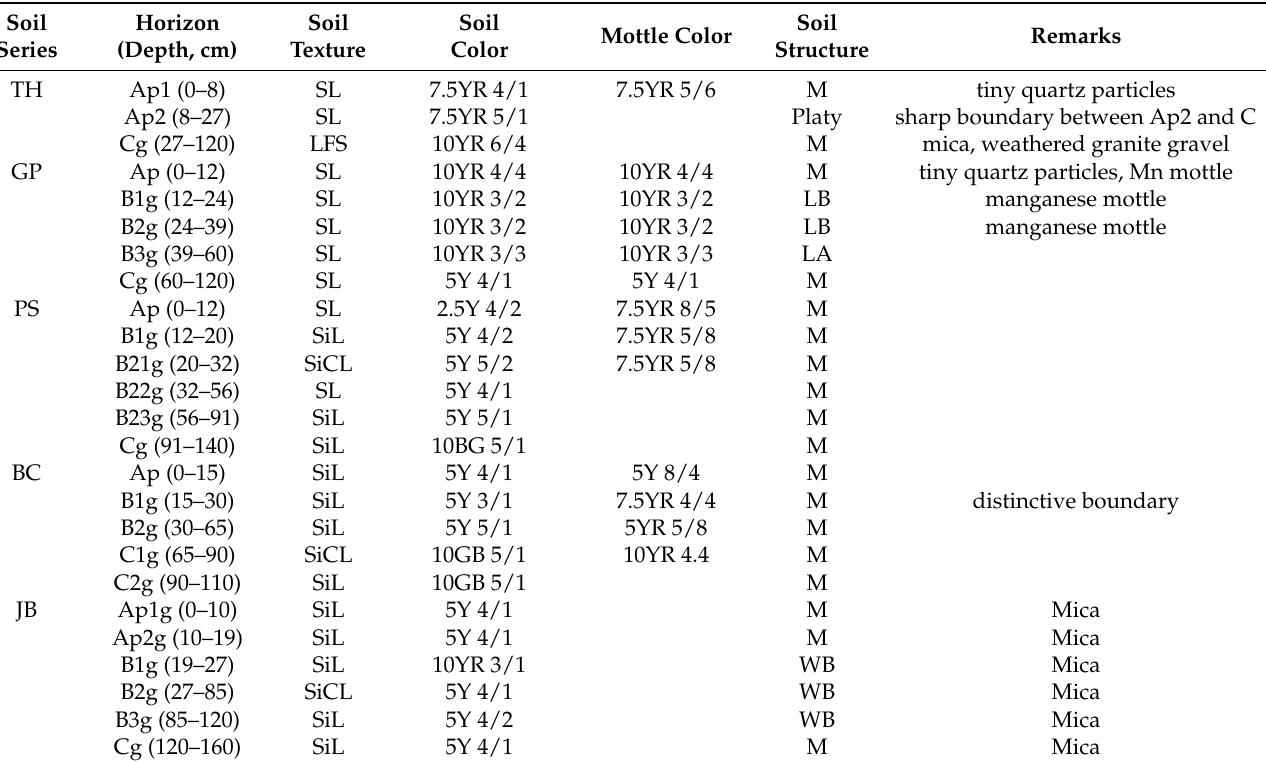
Figure 1. Photographs of the profiles of five soil series recovered from the investigation site. For soil properties (sand, silt, clay, BD, and OM), a total of 150 undisturbed soil core samples (US) were collected using stainless steel cylinders (5.1 cm diameter and 5.0 cm height) at 30 identifiable Ap horizons from each soil series for five soil series. Another 150 US were also taken for measurement of soil water retention curves using a soil core sampler with two wedge coring tips (Soil sampler 200, Soil moisture Equipment Corp., Goleta, CA, USA). Tables 1 and 2 present the soil profile descriptions including soil horizon, soil texture, and soil structure for the five-soil series that were obtained by the procedures of the Soil Survey Manual [18], and Figure 1 shows the texture distribution plotted on the textural triangle. The soil texture and organic matter (OM) were determined by the hydrometer [19] and the Walkley–Black [20] methods, respectively. BD was determined after drying the US at 105 ◦ C for 48 h. The porosities were calculated in accordance with the measured bulk density and particle density (2.65 g cm − 3 ) [21]. Table 1. Description of soil profiles of the five-soil series at the investigation site.